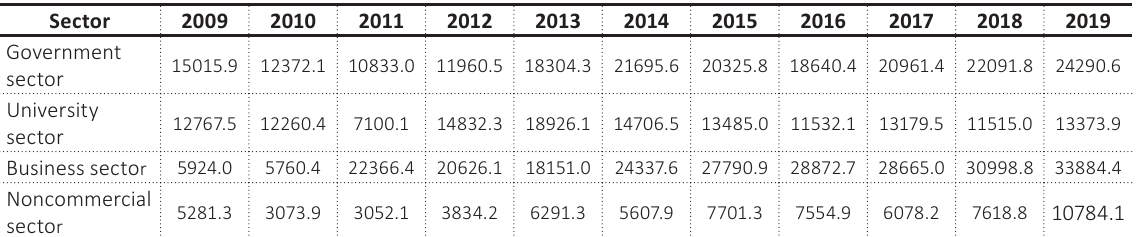
Source: Bureau of National Statistics